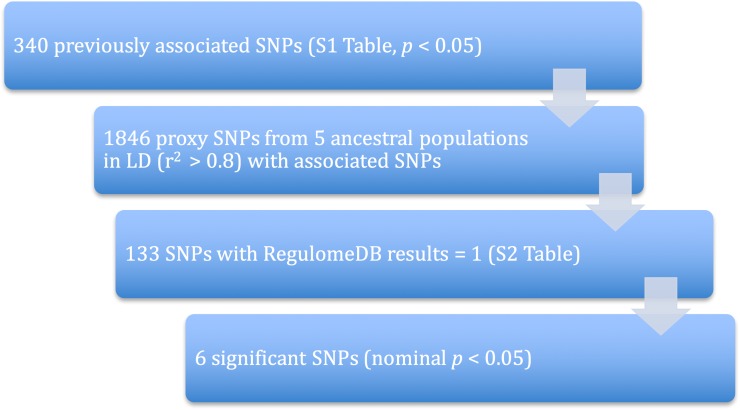
Bioinformatics pipeline for the prioritization of variants.